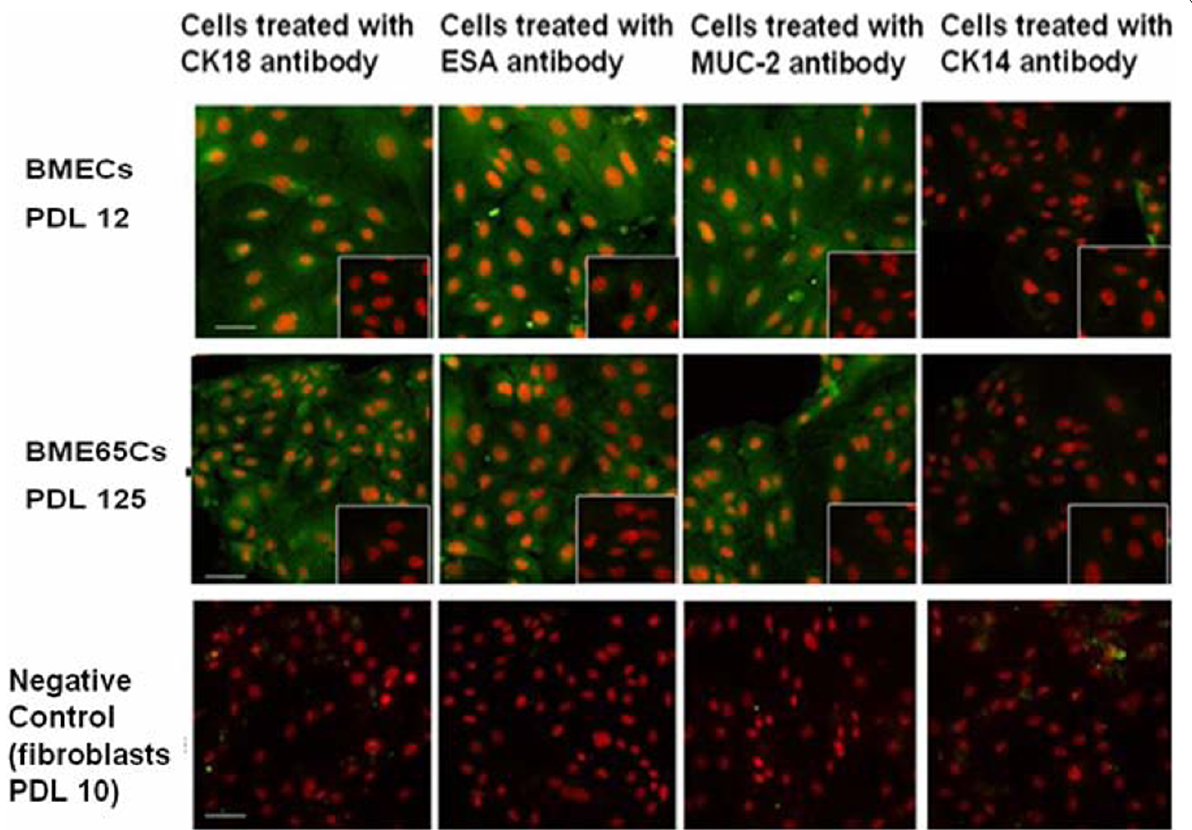
Figure 2 Immunostaining of specific mammary epithelial cell protein markers . Staining for CK18, ESA, MUC-2, and CK14 were observed in BMECs and BME65Cs cells, whereas staining for the isotype controls was faint (small pictures in bottom- right corner). PI was added as an immunofluorescence counterstain. Bars: 20 μ